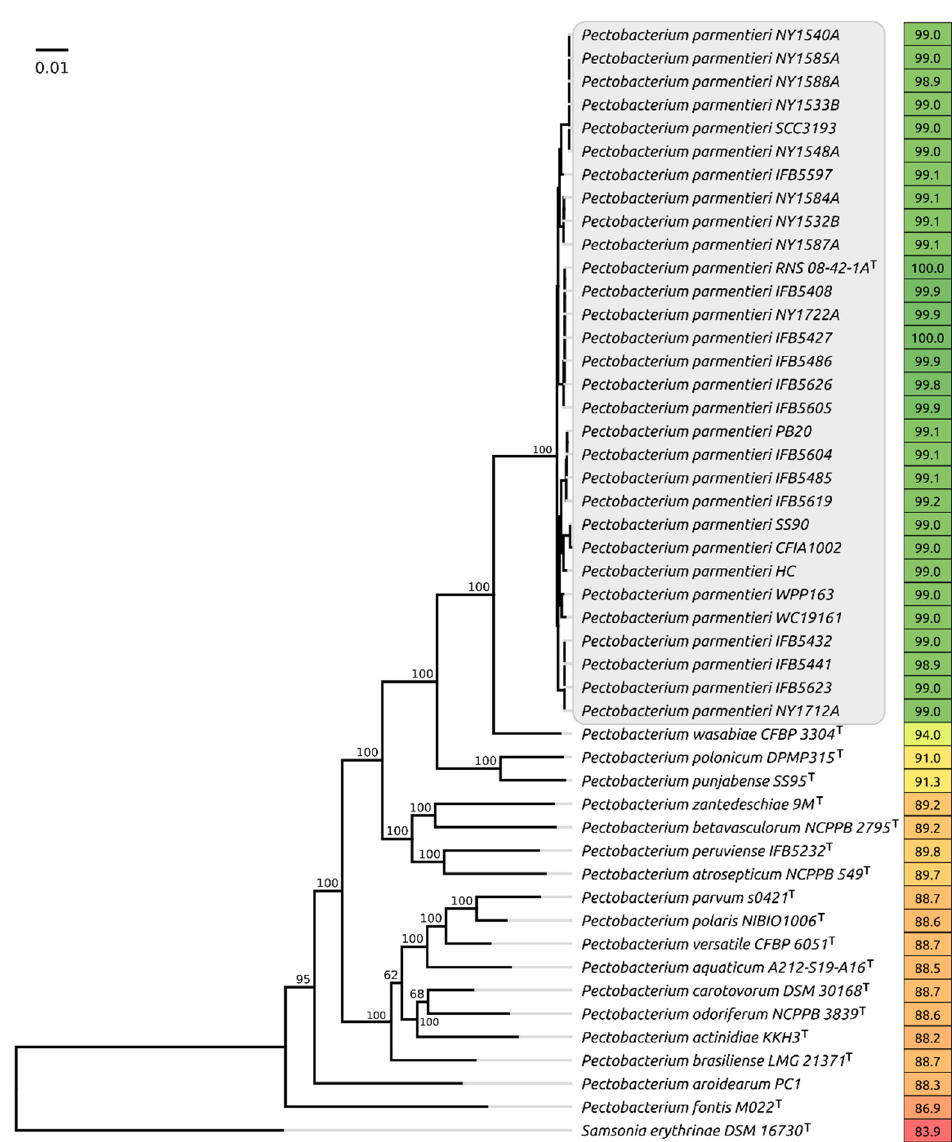
Figure 1. Phylogenetic tree based on the concatenated nucleotide sequences of 92 conservative genes, including the genes of ribosomal proteins and the proteins essential for the transcription and translation processes. Bootstrap support values are shown above their branch as a percentage of 1000 replicates. The scale bar shows 0.01 estimated substitutions per site, and the tree was rooted to Samsonia erythrinae DSM 16730 . Average nucleotide identity (ANI) values compared to P. parmentieri RNA 08-42-1A type strain are shown to the right of the organism name and coloured according to a heat map scale, where a green colour corresponds to the highest value and a red colour corresponds to the lowest value.